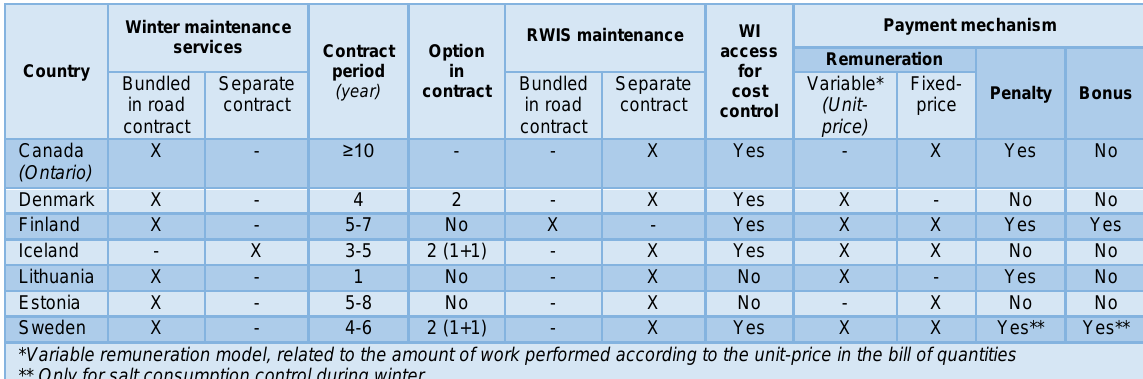
Table 3 International benchmarking of winter road maintenance contracts Due to the limited response to the benchmarking survey, it is uncertain to what extent WI is used in other